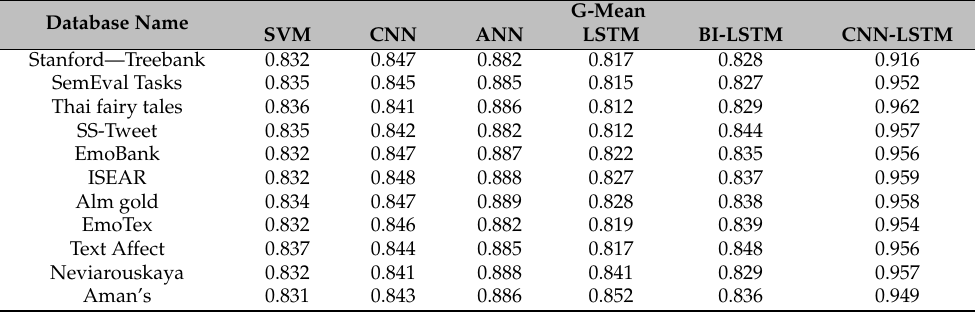
Table 10. Performance analysis for BOW + IF-IDF with CNN-LSTM based on